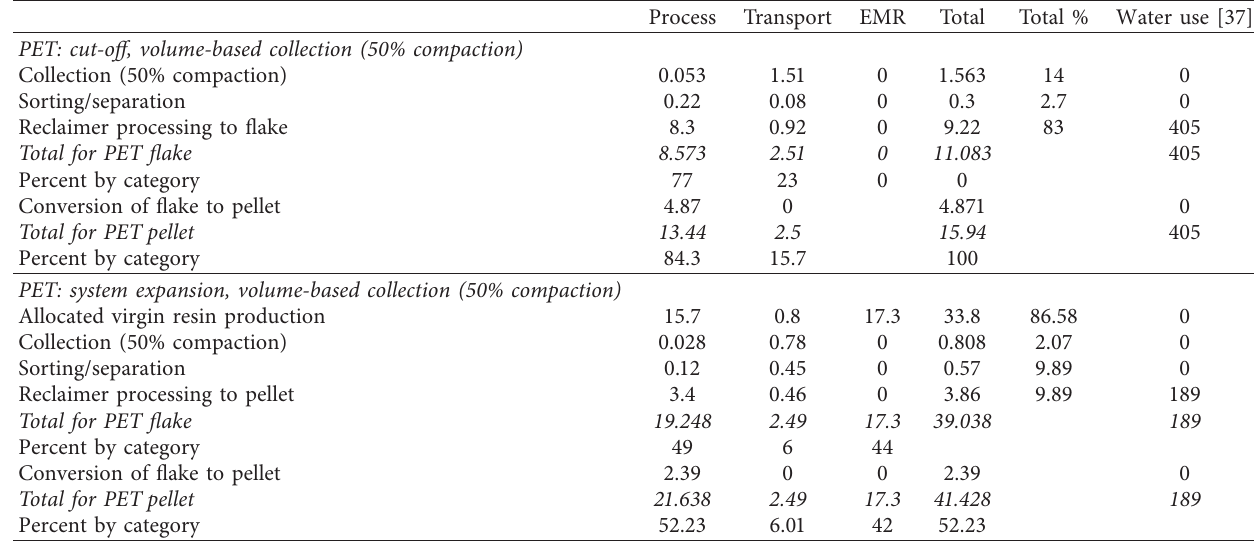
Table 9: Energy and water use for recycled PET resin (MBtu of energy and liter of water per ton of resin).